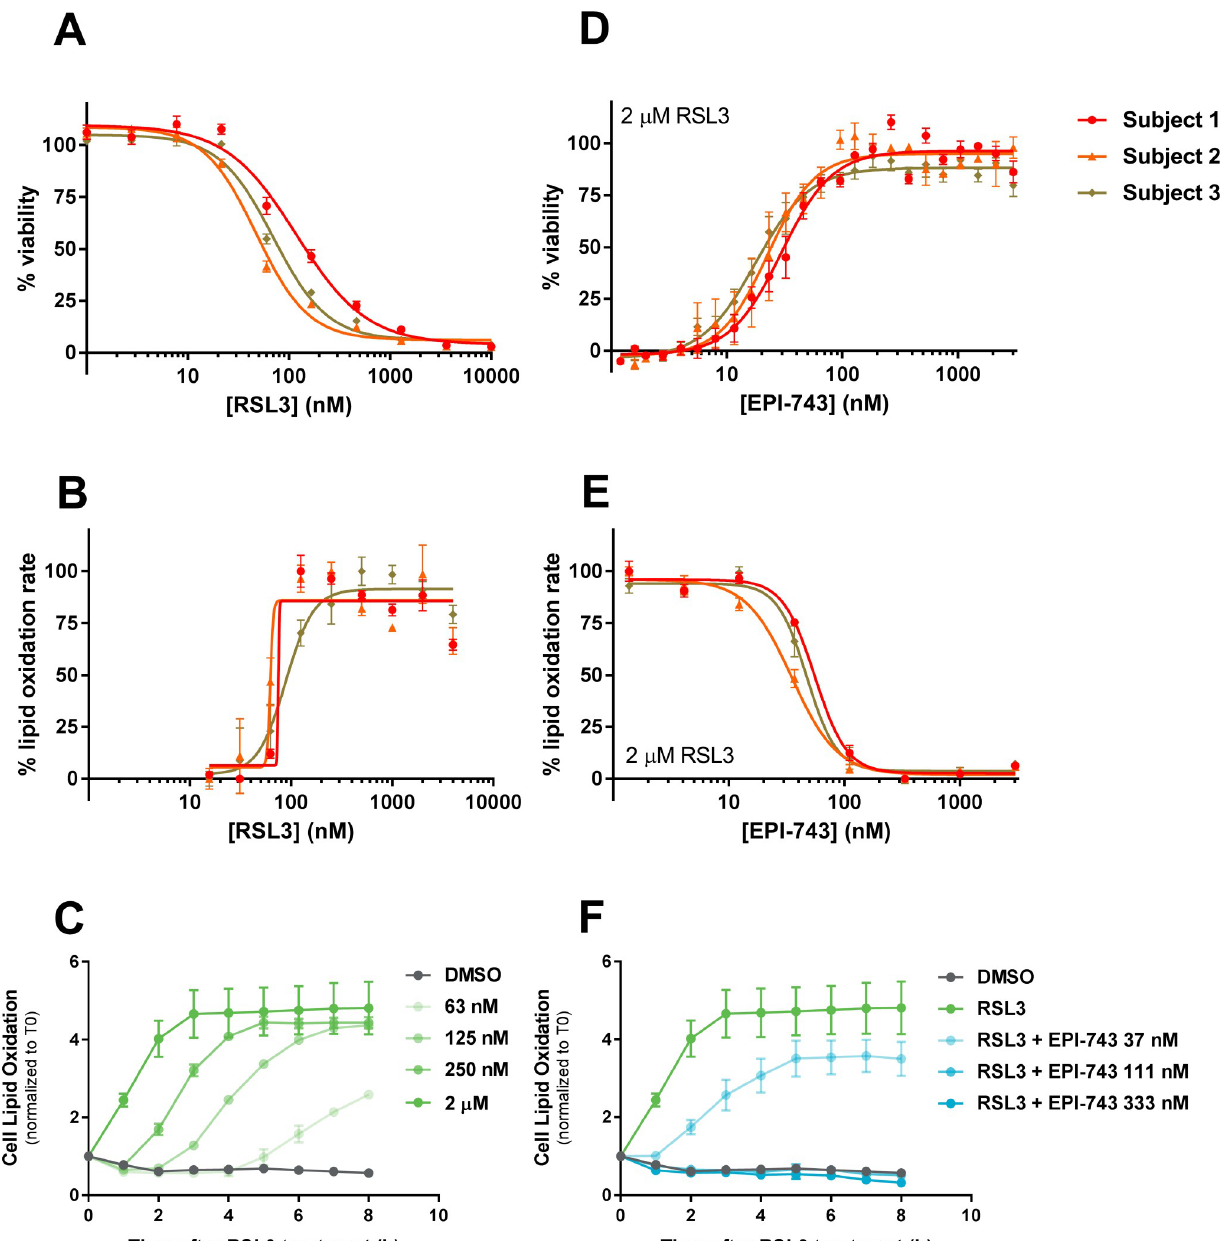
Fig 1. EPI-743 rescues PCH6 patient fibroblasts from RSL3-induced lipid oxidation and ferroptosis. (A) Dose-dependent reduction in viability of PCH6 patient cells by RSL3 treatment (N = 6–8 replicates for each patient cell summarized). Cell viability was assessed 18 h after RSL3 treatment using CellTiter-Glo 2.0 reagent to quantify cellular ATP. (B) The potency of RSL3-induced BODIPY 581/591 C11 lipid oxidation mirrors that of cytotoxicity (N = 6 replicates per patient culture). (C) Dose- and time-dependent BODIPY 581/591 C11 lipid oxidation in PCH6 patient fibroblasts, as measured by time-lapse microscopy (N = 2 independent experiments per patient culture, representative data from Subject 1 shown). (D) EPI-743 dose-dependently protected PCH6 patient fibroblasts from ferroptosis induced by RSL3 (2 μ M, 18 h). Dose-response curves are representative of 5–9 independent experiments summarized in Table 2. (E) EPI-743 dose-dependently decreased the rate of cellular BODIPY 581/591 C11 oxidation following RSL3 (2 μ M) treatment (N = 6 replicates per patient culture). (F) Time course of EPI-743 prevention of BODIPY 581/591 C11 lipid oxidation (N = 2 independent experiments per patient culture, representative data from Subject 1 shown). Mean ± SEM displayed along with best 4-parameter curve fits (A, B, D,